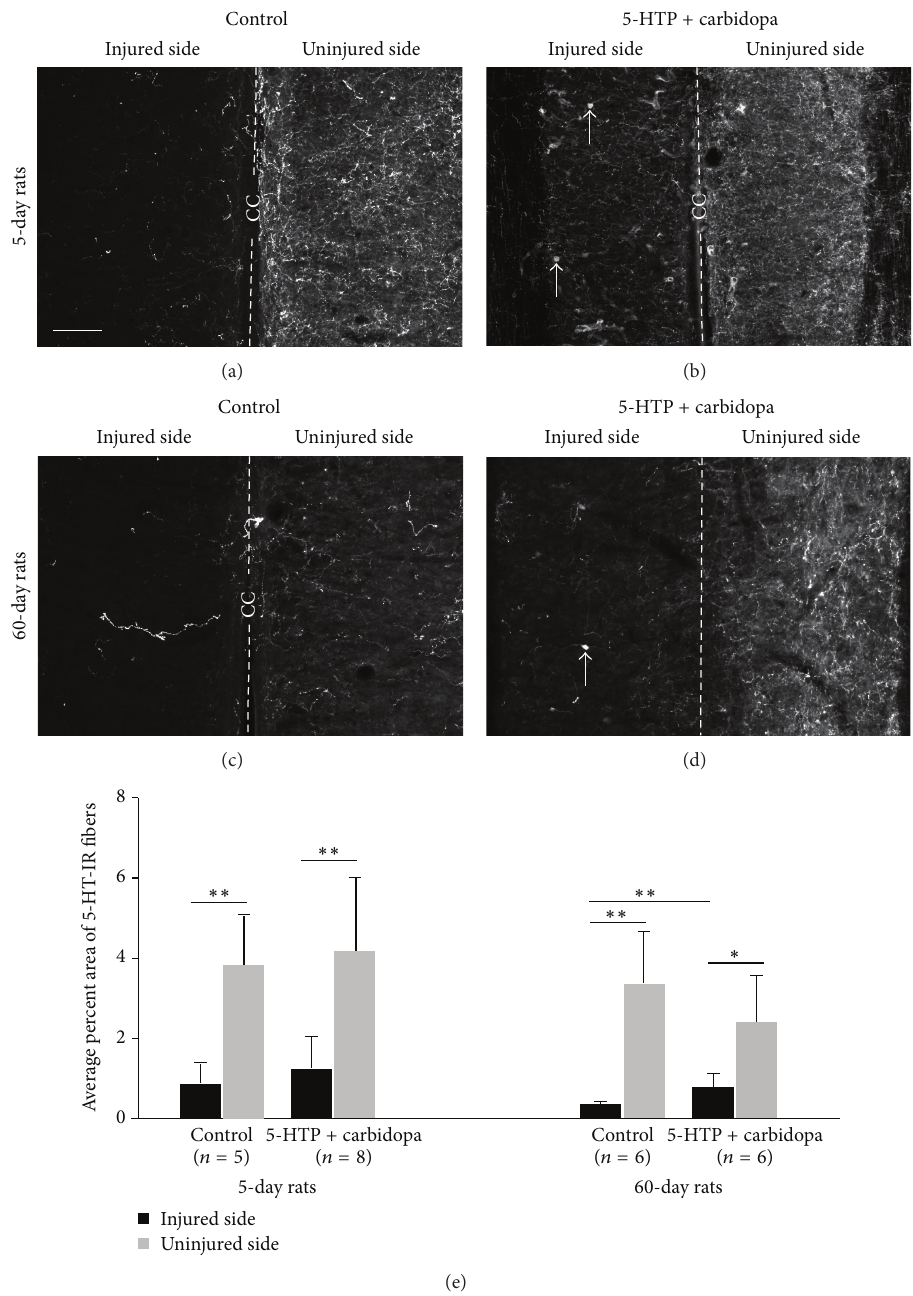
Figure 1: 5-HT-immunoreactive (IR) nerve fibers in the intermediate zone in the sacrocaudal spinal cord on the injured and uninjured side in different animal groups. (a–d) Photomicrographs of 5-HT-IR fibers in 5-day untreated group (a) and 5-HTP plus carbidopa treated group (b) and in 60-day untreated group (c) and 5-HTP plus carbidopa treated group (d). Dashed line represents the midline in each horizontal section. CC: central canal. Arrows in (b) and (d) indicate 5-HT-immunoreactive cells. Scale bar in (a), 100 𝜇 m. (e) Quantitative data of the density of 5-HT-IR fibers in different animals groups. ∗ 𝑃 < 0.05 , ∗∗ 𝑃 < 0.01